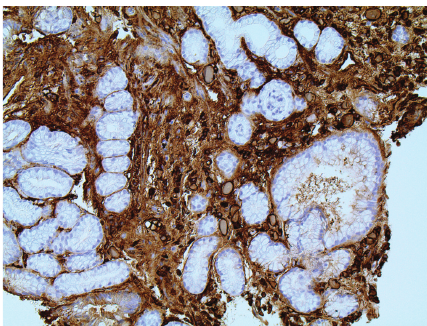
Figure 5: Kappa light chain immunostain , 20x . The Russell body- laden plasma cells show both kappa and lambda (i.e., polyclonal) immunoglobulin expression.